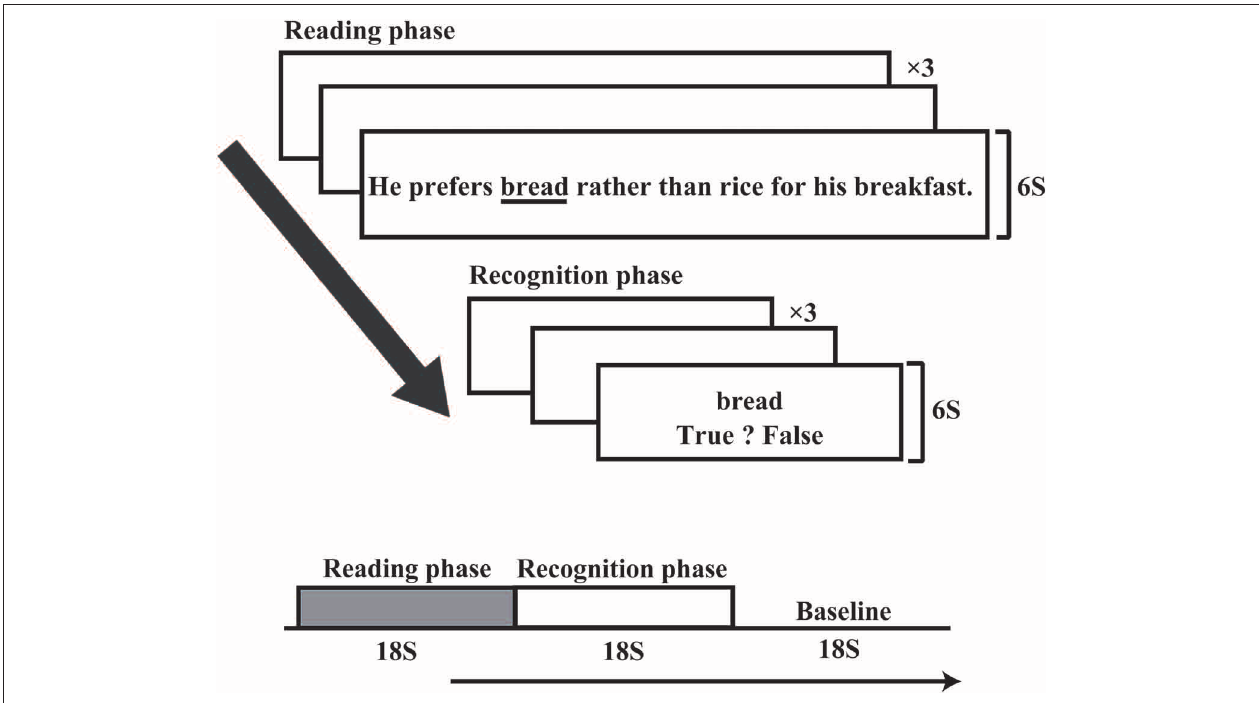
FIGURE 2 | Experimental time course of the RST. One experimental block comprised three sentences. After three sentences were presented, three probe stimuli appeared at 6s intervals. Reading and recognition phases each took 18s, followed by an 18s baseline